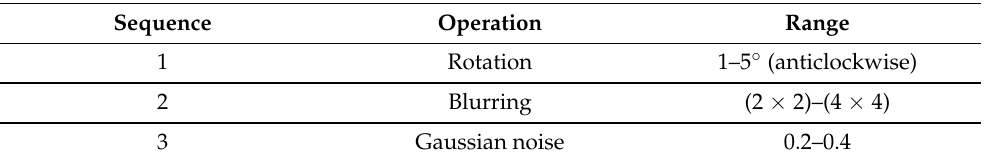
Table 2. Operations applied to each reference CSR response (from Process One) for obtaining the set of retaken images.